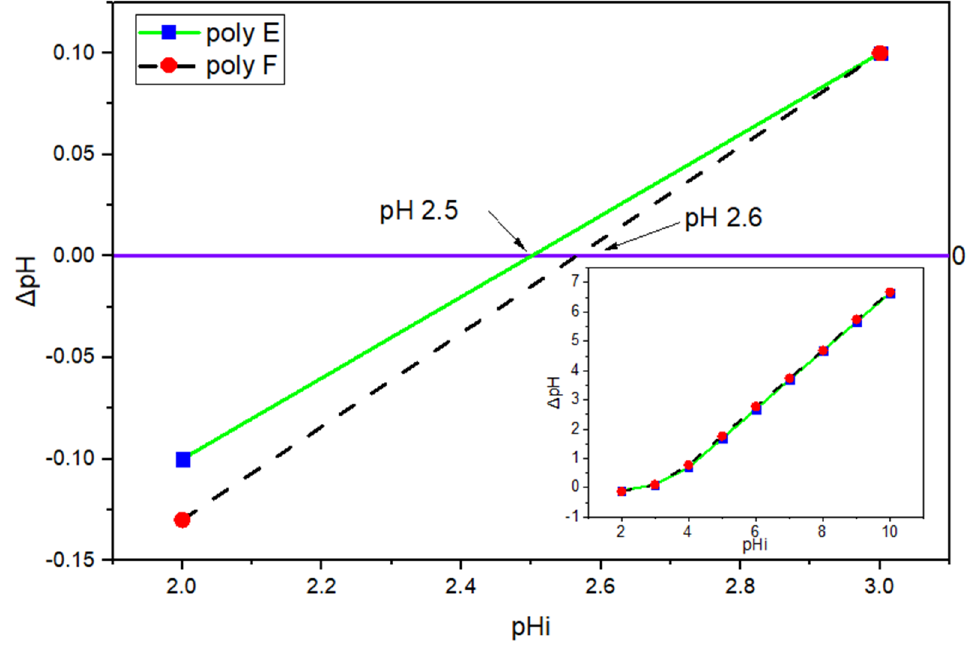
Figure 2. Relation between Δ pH and initial pH and pH PZC conclusion.